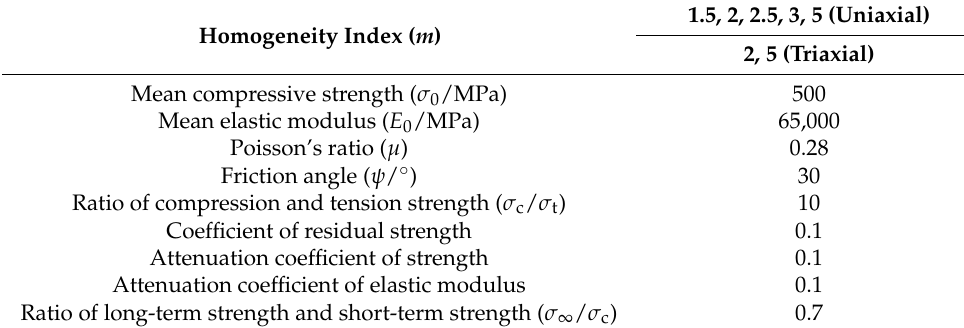
Table 1. Rock material parameters of the numerical